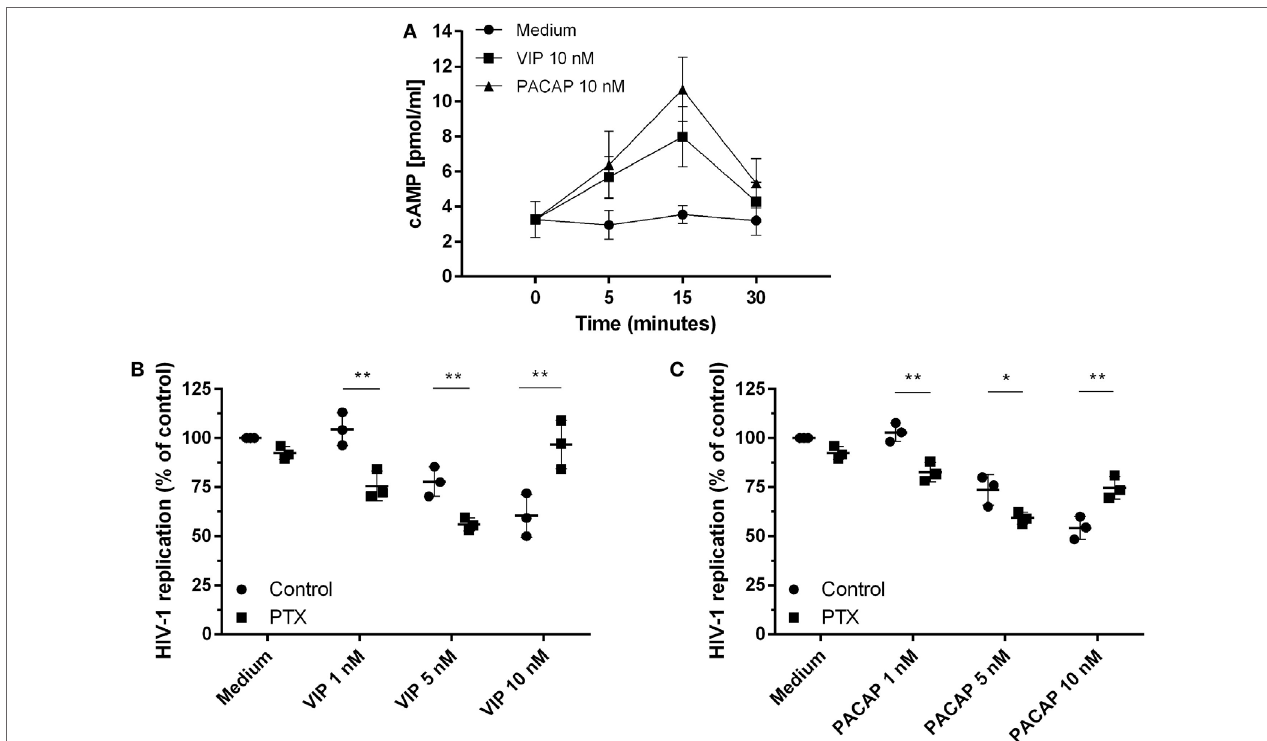
FigUre 2 | Activation of cAMP signaling contributes to vasoactive intestinal peptide (VIP) and pituitary adenylate cyclase-activating polypeptide (PACAP)-induced HIV-1 inhibition in macrophages. (a) Uninfected macrophages were treated with VIP or PACAP (10 nM) and intracellular cAMP levels were analyzed by ELISA at different time points ( n = 3). (B,c) HIV-1-infected macrophages were exposed to pertussis toxin (25 pg/mL) and, 3 h later, cells were washed and treated with VIP or PACAP at different concentrations. Supernatants were collected after 12 days and viral replication was measured ( n = 3). * p < 0.05; ** p < 0.01; ns, not significant; two-way ANOVA, with Tukey